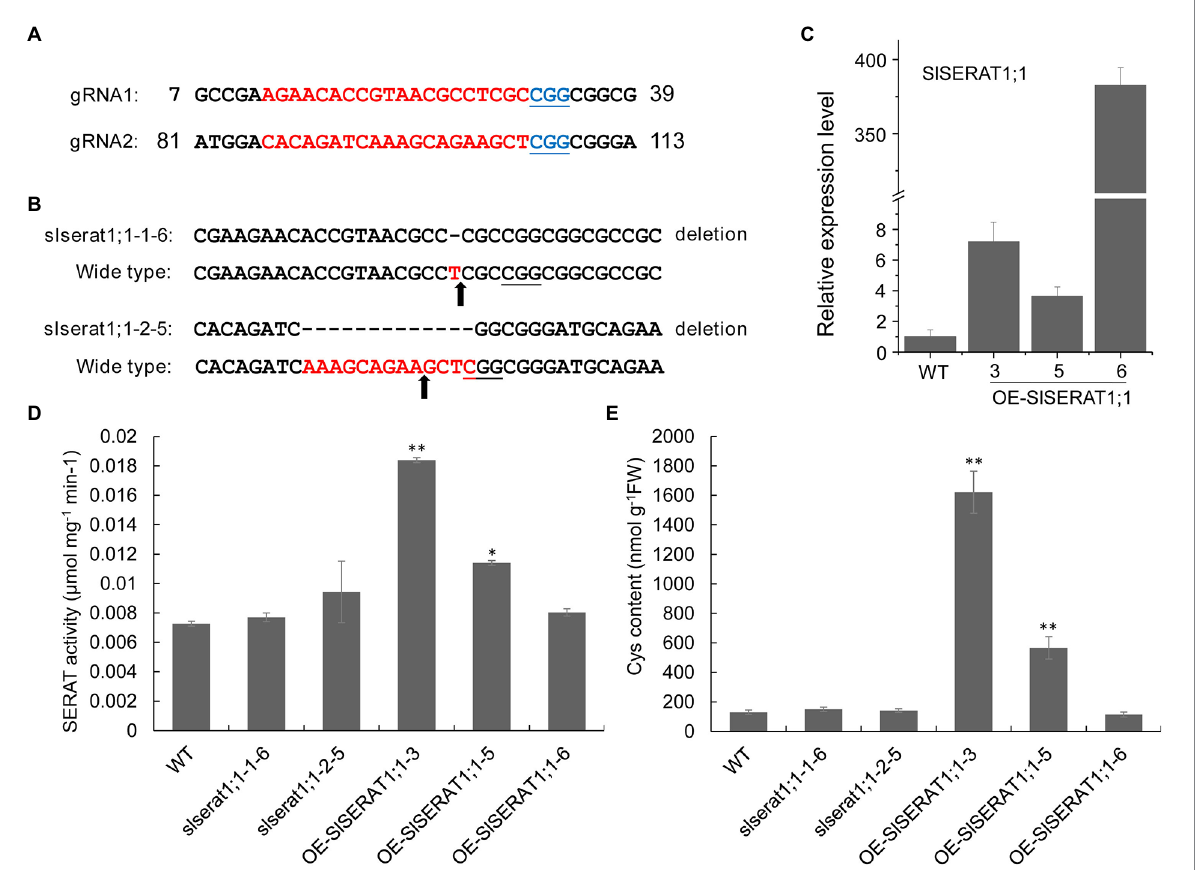
FIGURE 7 Function analysis of SlSERAT1;1 in the loss-of-function and over-expression lines. (A) gRNA design for the gene editing of SlSERAT1;1. the gRNA target and the protospacer-adjacent motif (PAM) are indicated in red and blue, respectively. (B) The mutation patterns in slserat1;1-1-6 and slserat1;1-2-5. The PAM position was underlined, and the cleavage sites were indicated by arrowheads. (C) The expression levels of SlSERAT1;1 in the over-expression (OE-SlSERAT1;1) lines. (D) SERAT activity assays in loss-of-function and over-expression lines of SlSERAT1;1. (E) Cys content analysis in the transgenic